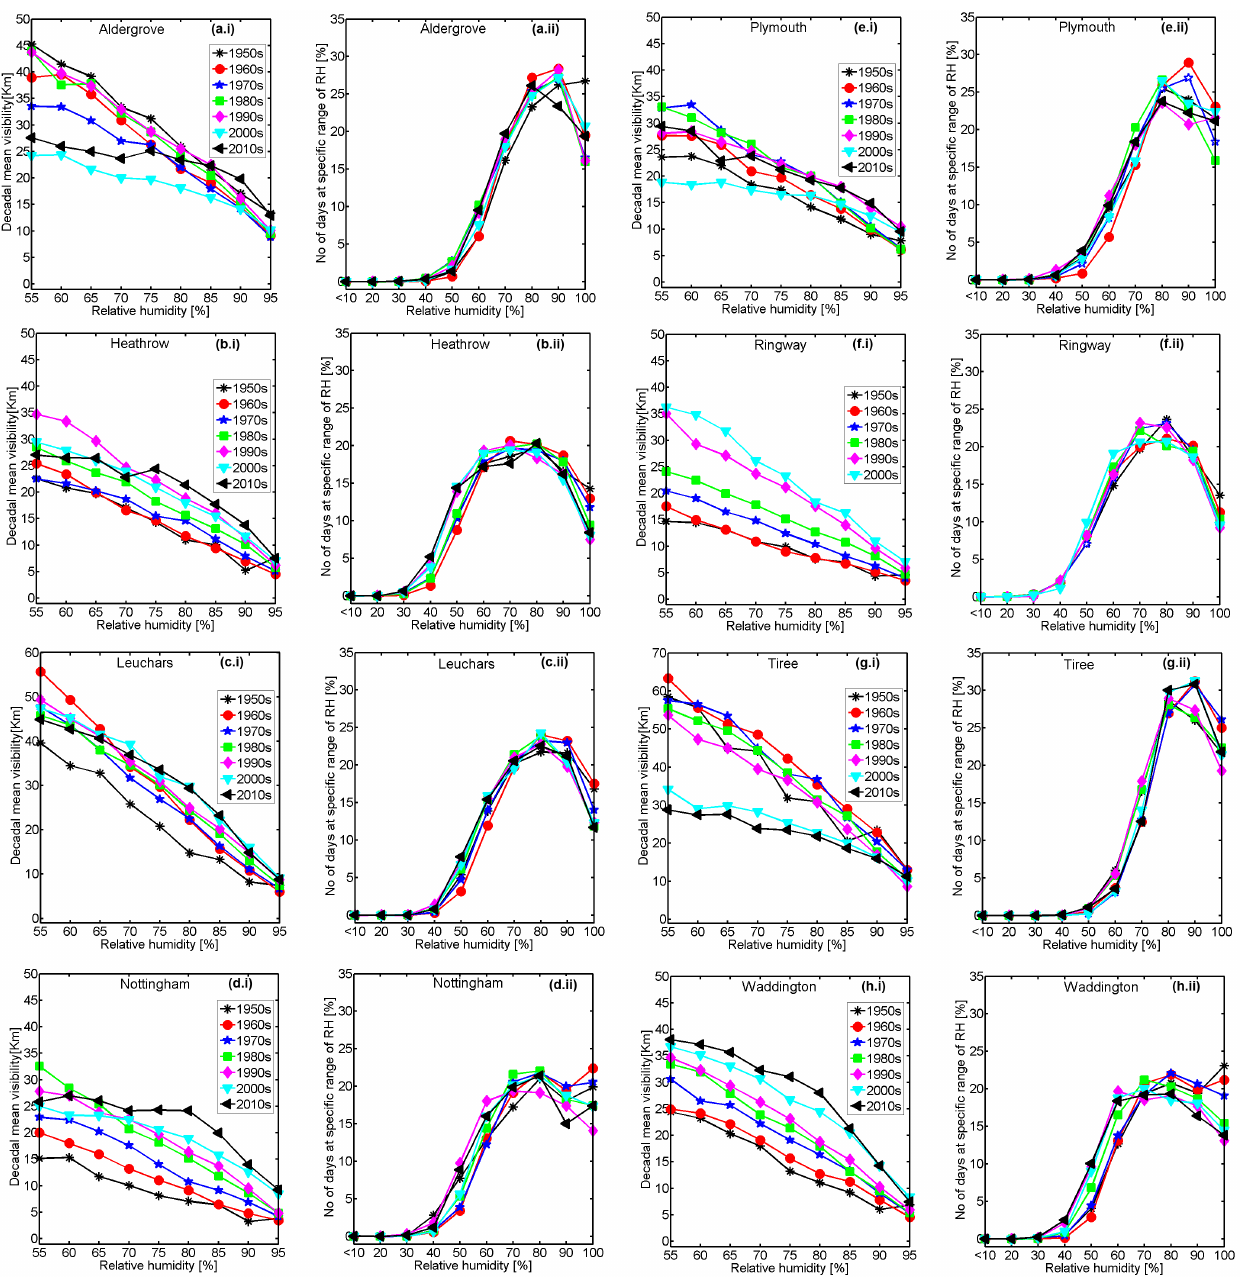
Figure 4. Decadal visibility in a specific range of relative humidity (left side) and number of days in percent during different relative humidity (right